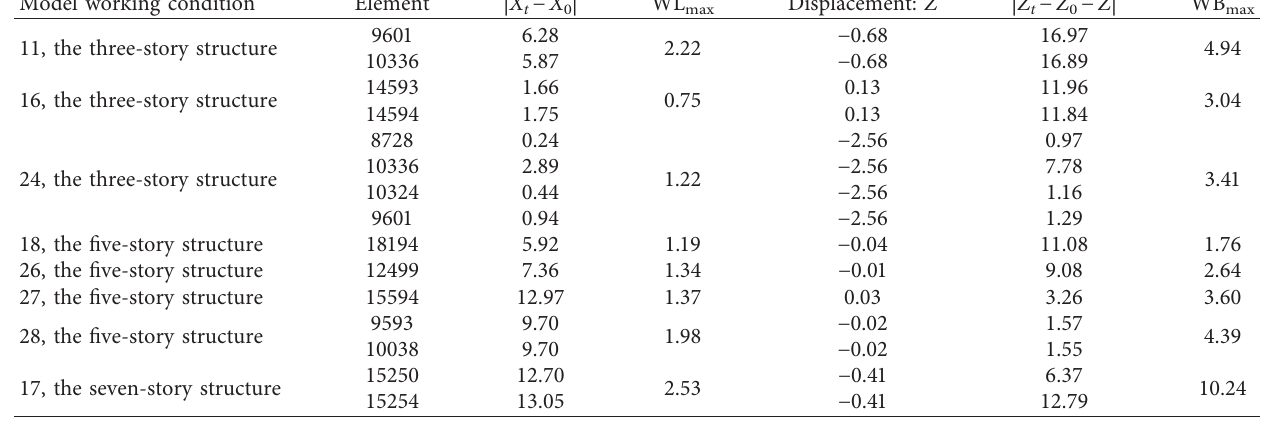
Table 5: The influence distance of effective flying stones element and the main influence distance of debris accumulation. Model working condition